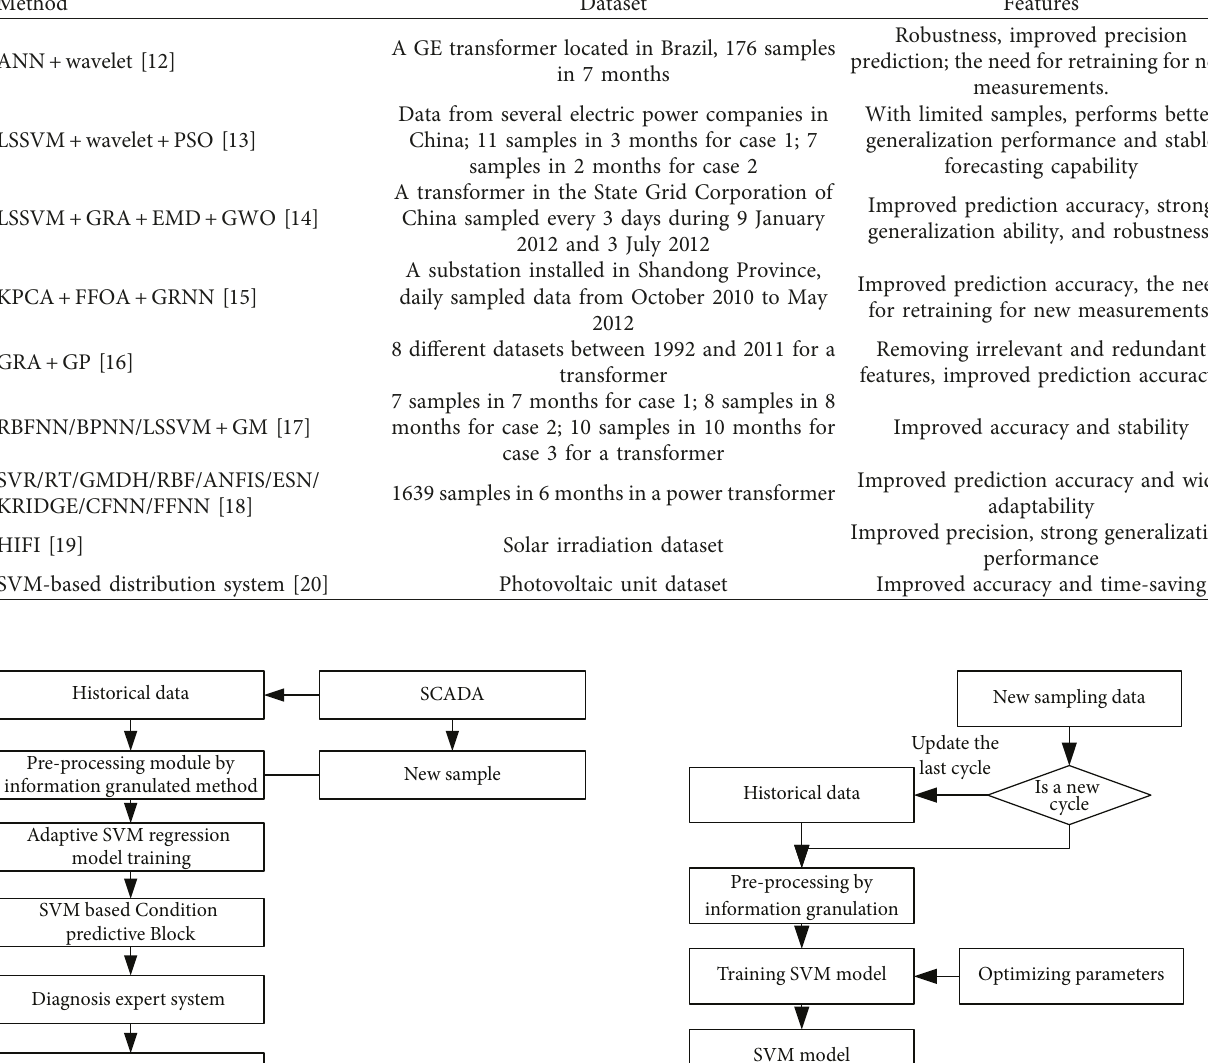
Table 1: Comparison of prediction methods of typical transformer dissolved gas and sequence data in recent years. Method